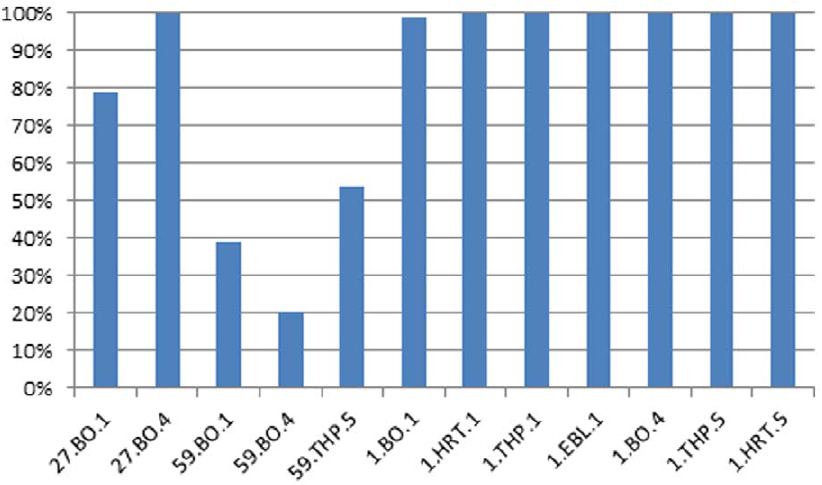
Figure 2. Percent of consensus SNPs that occur as subconsensus variants in unpassaged samples. The consensus sequence for each unpassaged parent sample was compared to its passaged descendants. For each sample that clustered away from the unpassaged parent (Figure 1), the percentage of passaged consensus SNPs that were present as variants in the unpassaged sample is shown on the y- axis. The x-axis shows the name of the passaged descendant identified by sample (1, 27, or 59), host cell type (BO, THP or HRT) and passage number (1, 4 or 5).